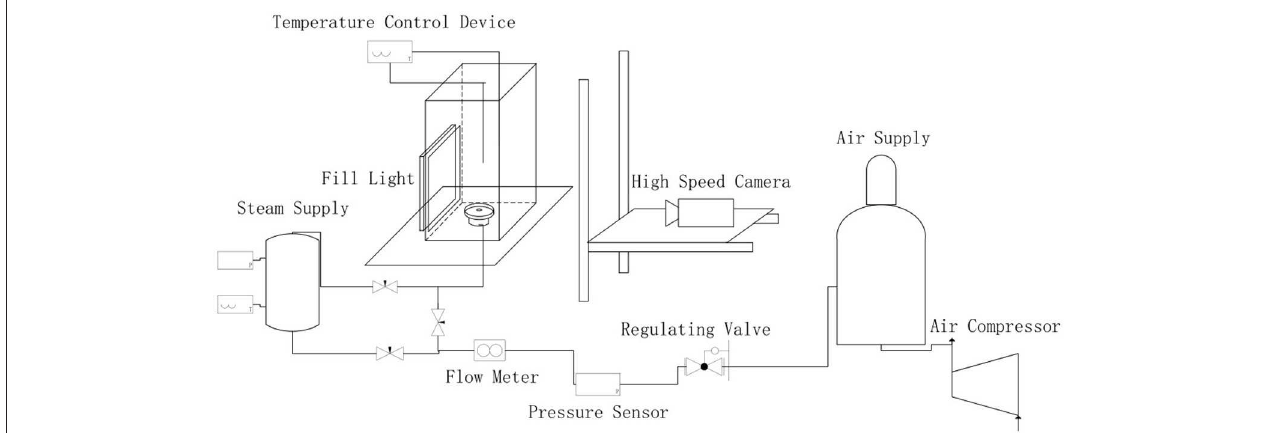
FIGURE 1 | Schematic of experimental